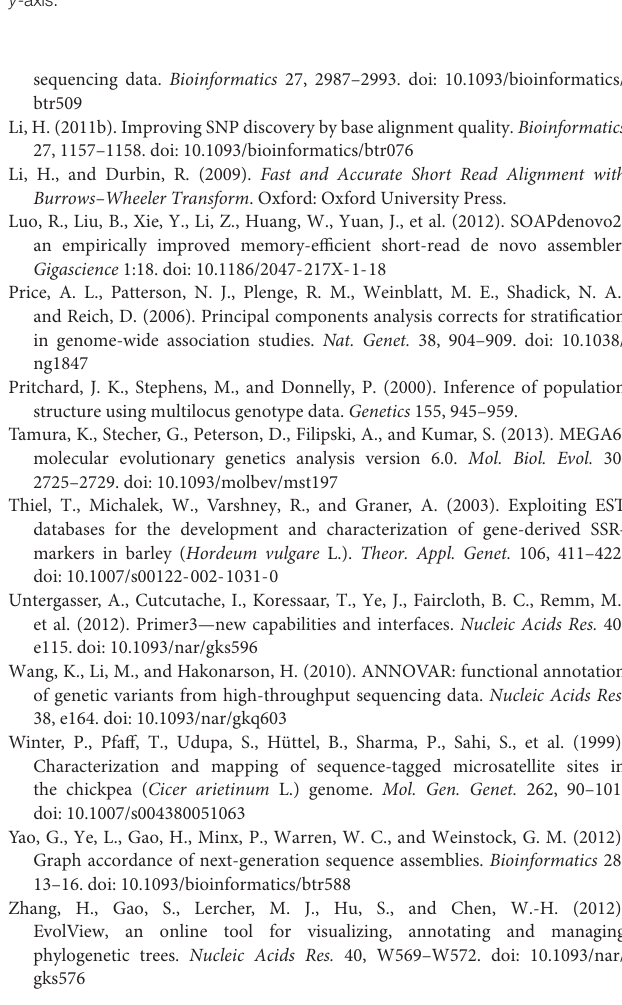
FIGURE S1 | (A) K -value selection of population structure for SNP. The picture of SNP-based k -value selection shows that 3 is the proper k -value, which is the highest value of the y -axis. (B) K -value selection of population structure for SSR. The picture of SSR-based k -value selection shows that 4 is the proper k -value, which is the highest value of the y